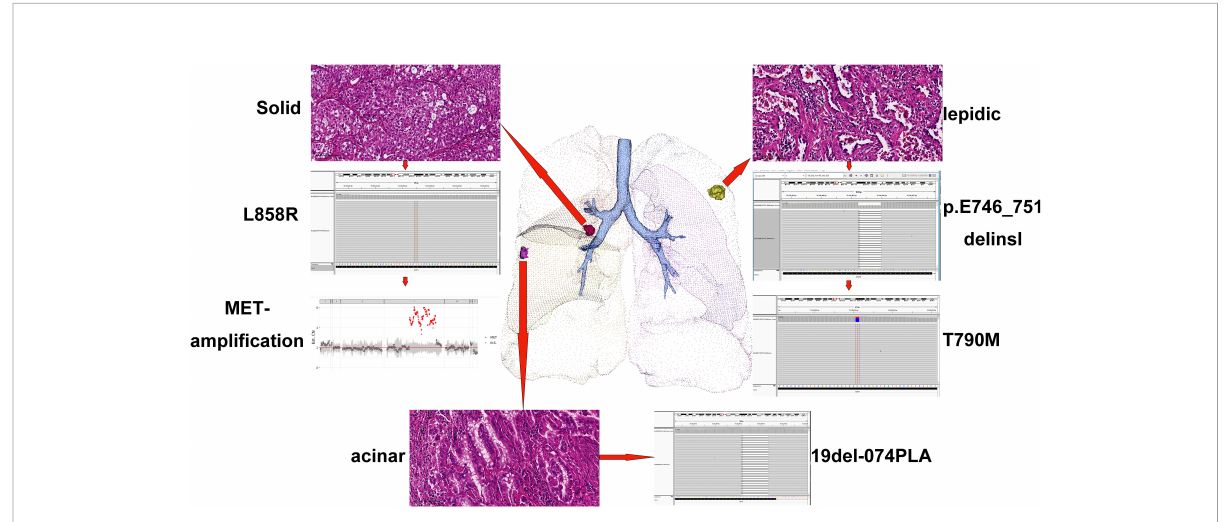
FIGURE 2 Location, pathology, and ongoing NGS-testing results of the three pulmonary lesions. NGS, next-generation